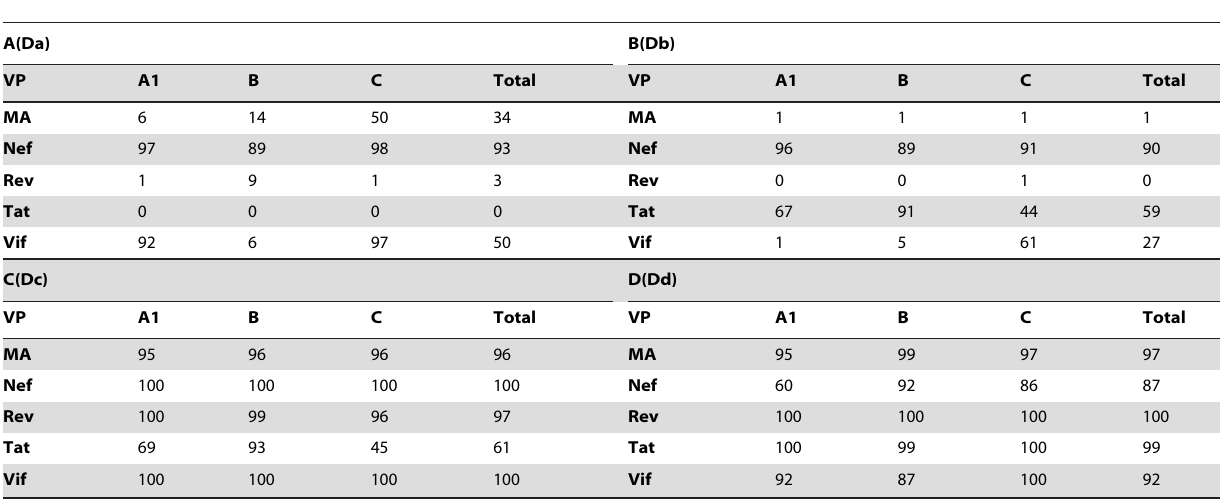
Table 2. MAPK docking pattern hits on HIV